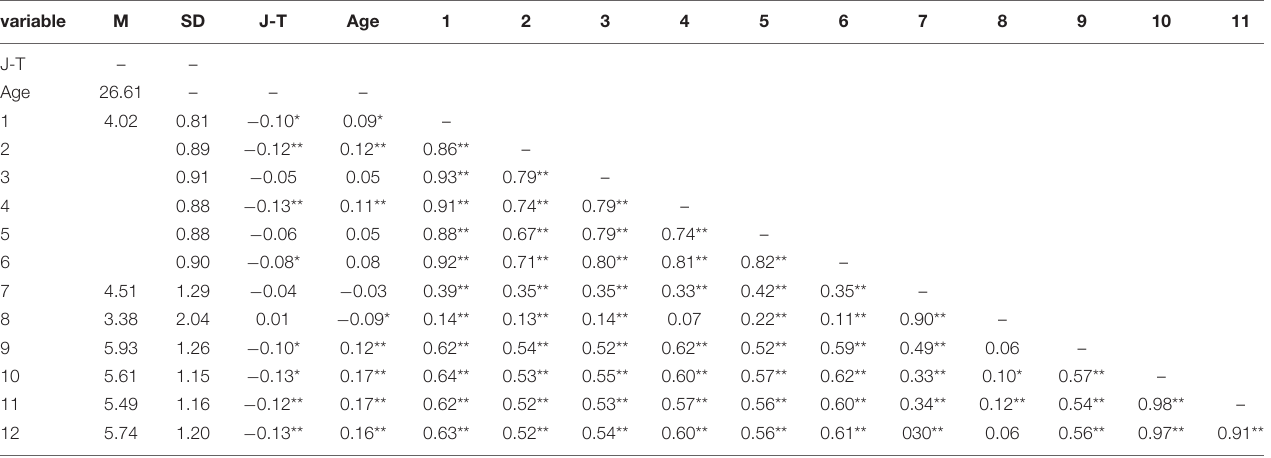
TABLE 2 | The correlation matrix of SBR, teaching beliefs, and teaching abilities.